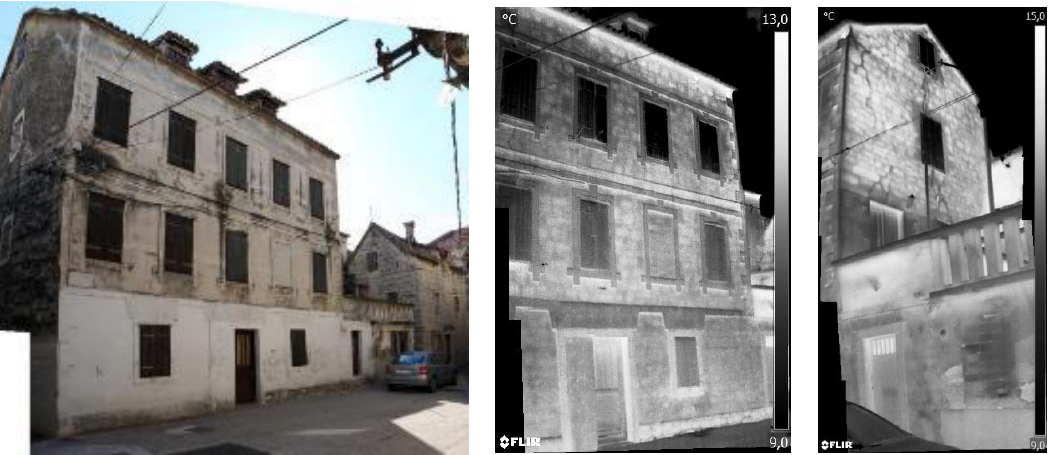
Figure 5. Thermographic examination of unreinforced stone masonry building partially covered with plaster, and significant cracks in a gable wall